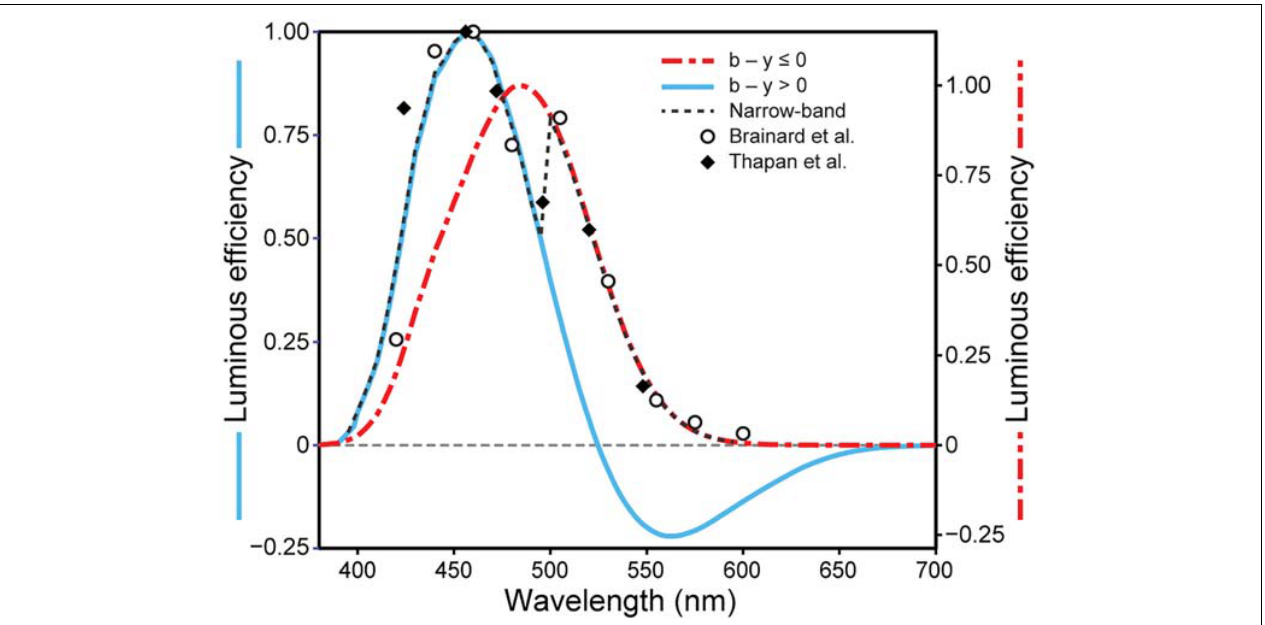
FIGURE 2 | The relative sensitivity of different narrowband wavelengths for suppressing nocturnal melatonin from Brainard et al. (2001) and Thapan et al. (2001). Also shown are the predictions from the two-state circadian phototransduction model (Eq. 1), for narrowband (achromatic dashed line) and for “warm” polychromatic lights where b-y ≤ 0 (red dot/dash line) and for “cool” polychromatic lights where b-y > 0 (blue solid line) when the overall flux density on the retina is 300 scotopic lx (Rea and Figueiro,